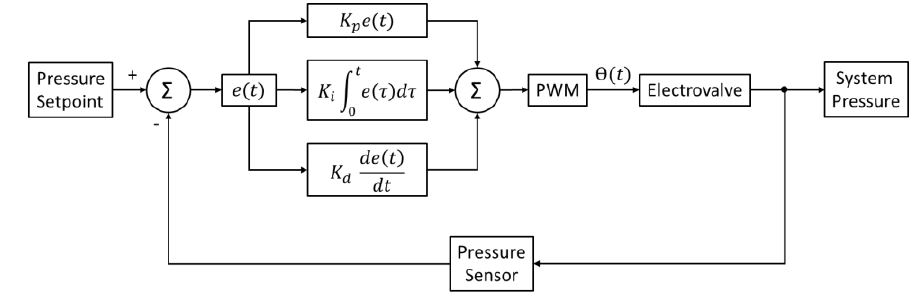
Figure A1 System pressure PID controller. Figure A1. System pressure PID